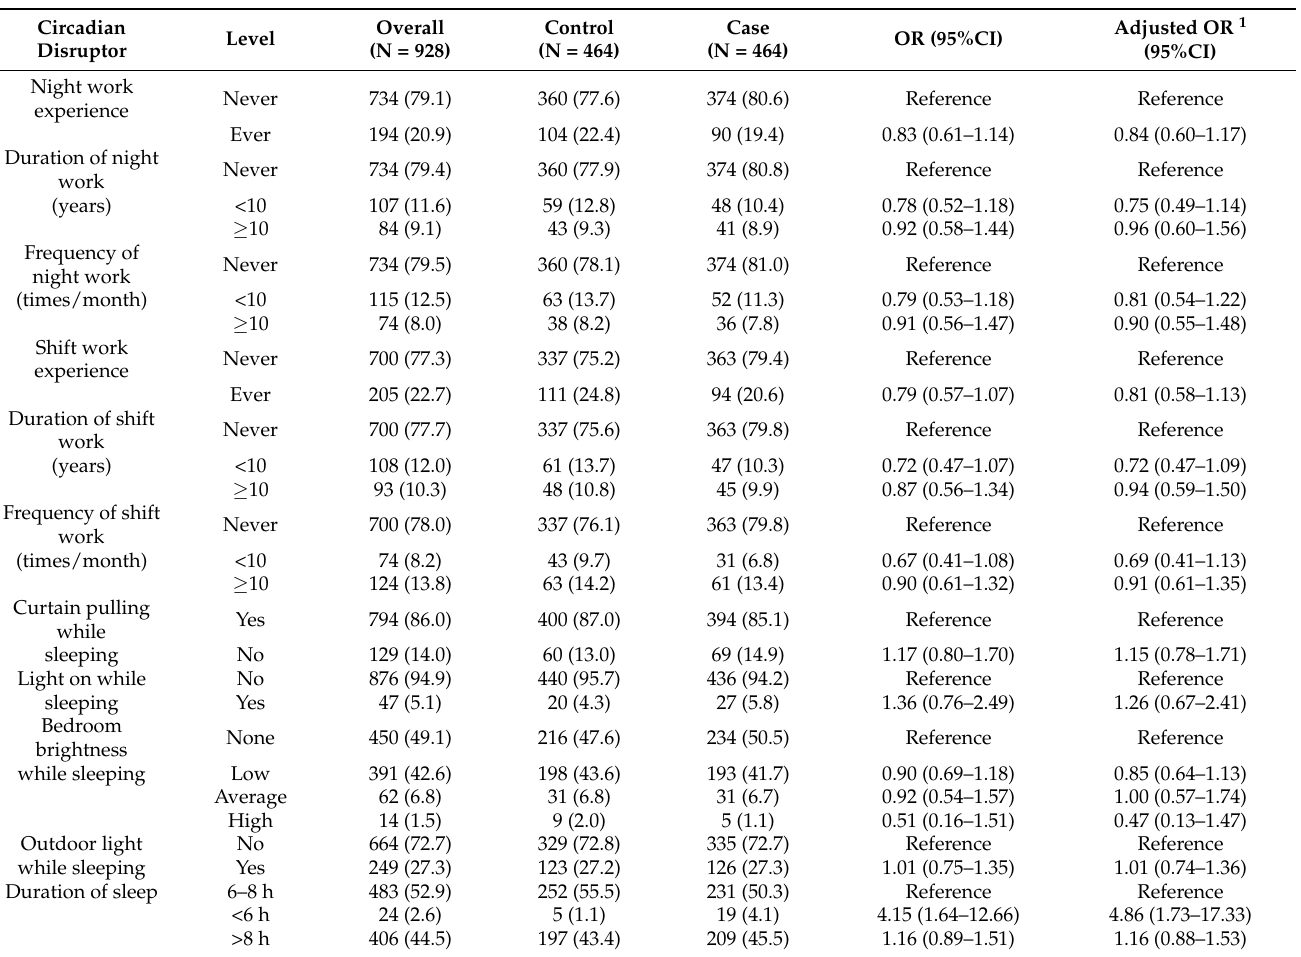
Table 2. Association between night shift work, domestic light at night, sleep duration, and breast cancer risk in univariate and multivariate logistic regression